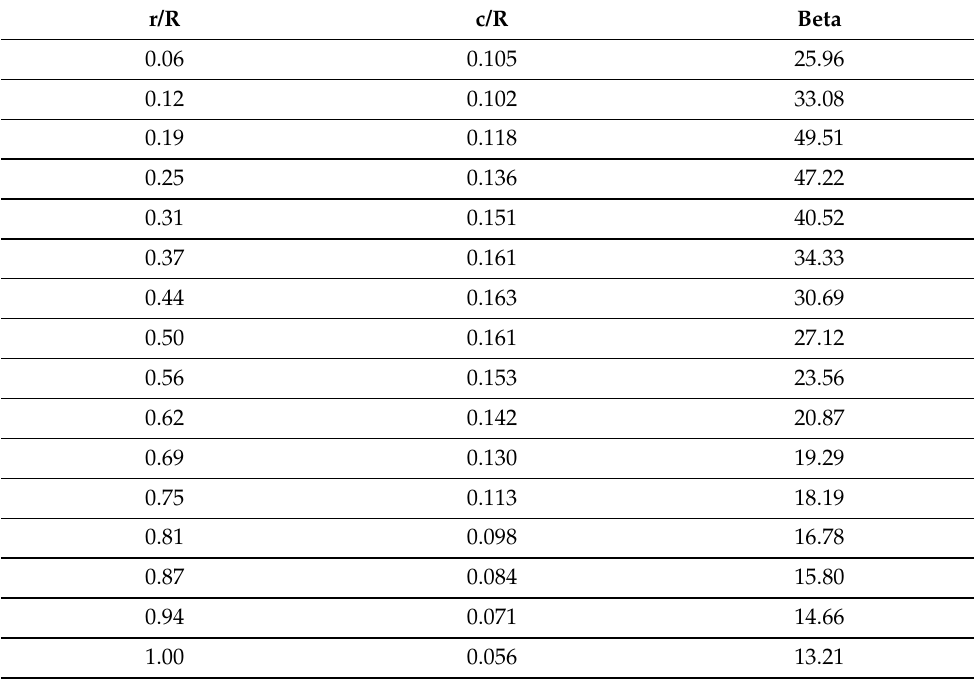
Table A2. APC 16 × 12 propeller geometry.